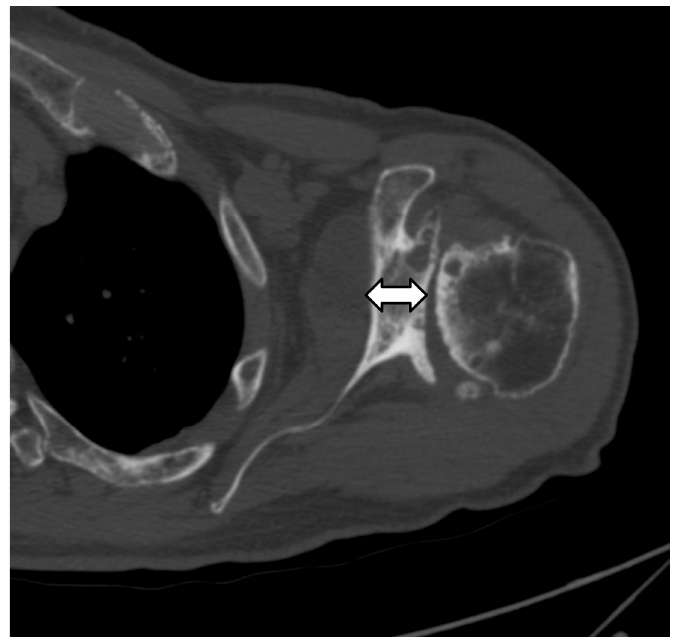
Figure 7. Axial CT image shows decreased glenoid bone stock (double arrow) due to glenoid erosion and retroversion.